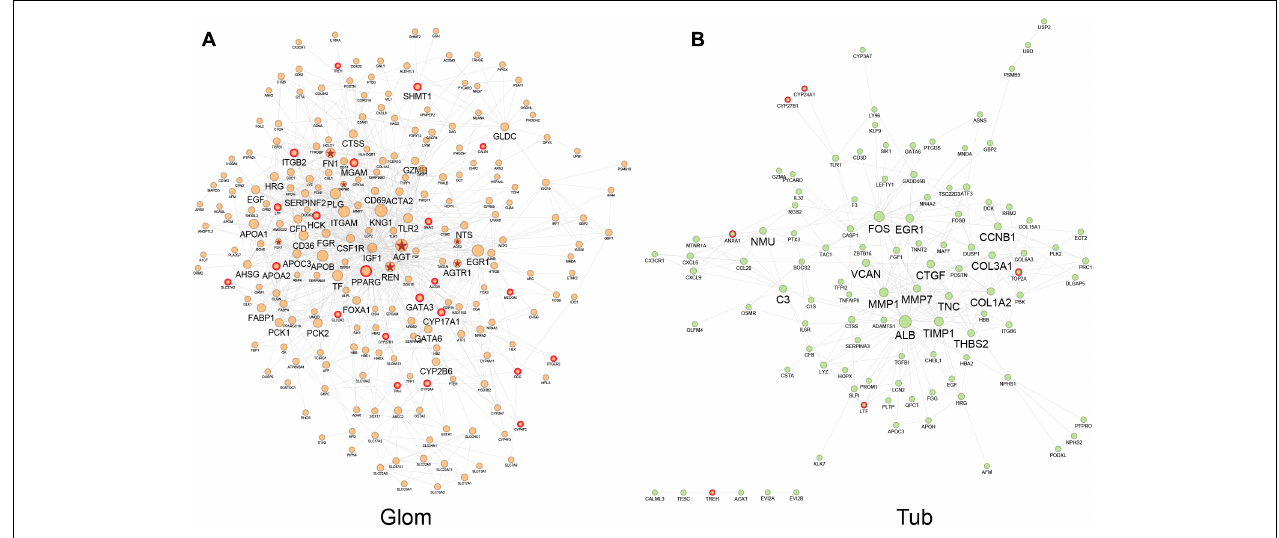
FIGURE 3 | Interaction network of DEGs in glomeruli (A) and tubules (B) . Node size changes with the node degree in network. The hub nodes were marked with big name labels and potential drug targets of QDZJN were marked with red edges. Nodes with red star label were disease genes related to HN from DisGeNET